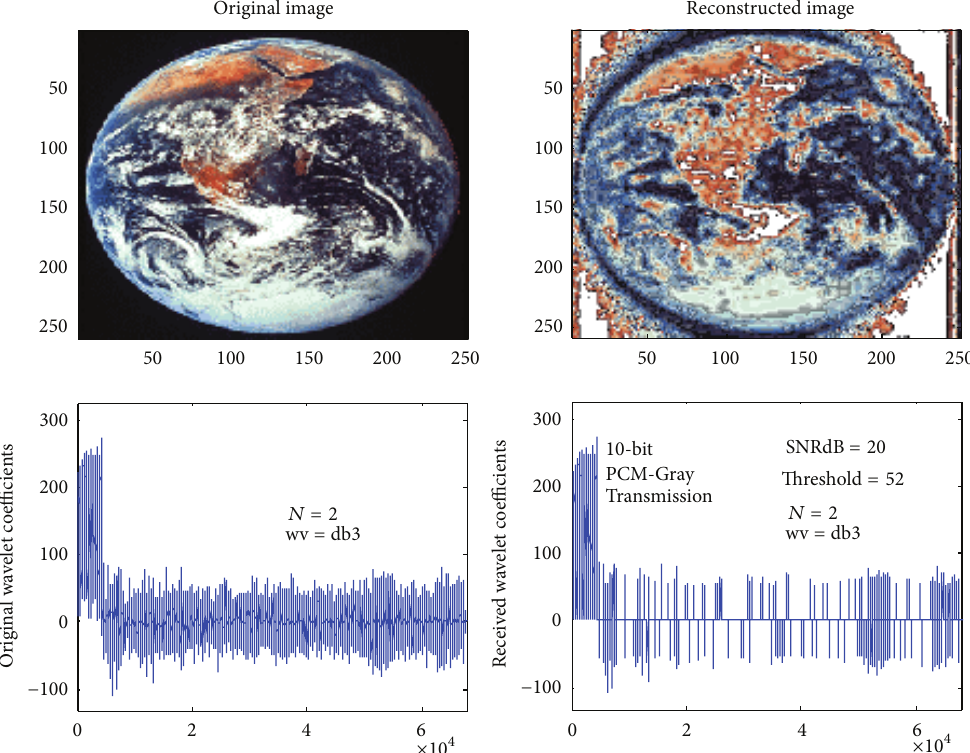
Figure 4: Original and reconstructed images with their wavelet coefficients using threshold wavelet compression. Threshold = 52, SNR = 20 dB, retained energy = 90.8, MSE = 1.51, and MSSIM =